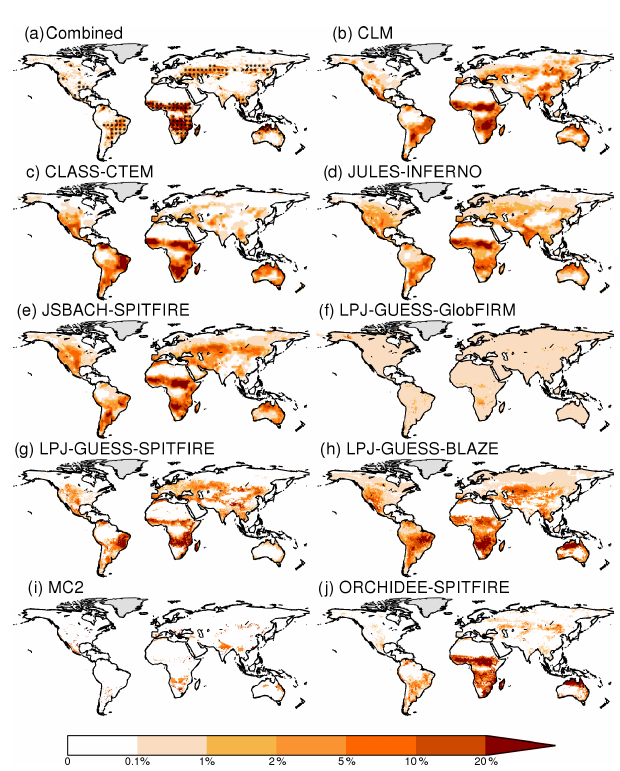
Figure 2. Simulated versus observed burnt fraction (%yr − 1 ) for the present day (2002–2012), where “combined” indicates the mean of the different burnt area datasets considered. Stippling indicates where variance between burnt area datasets is less than the observed ensemble